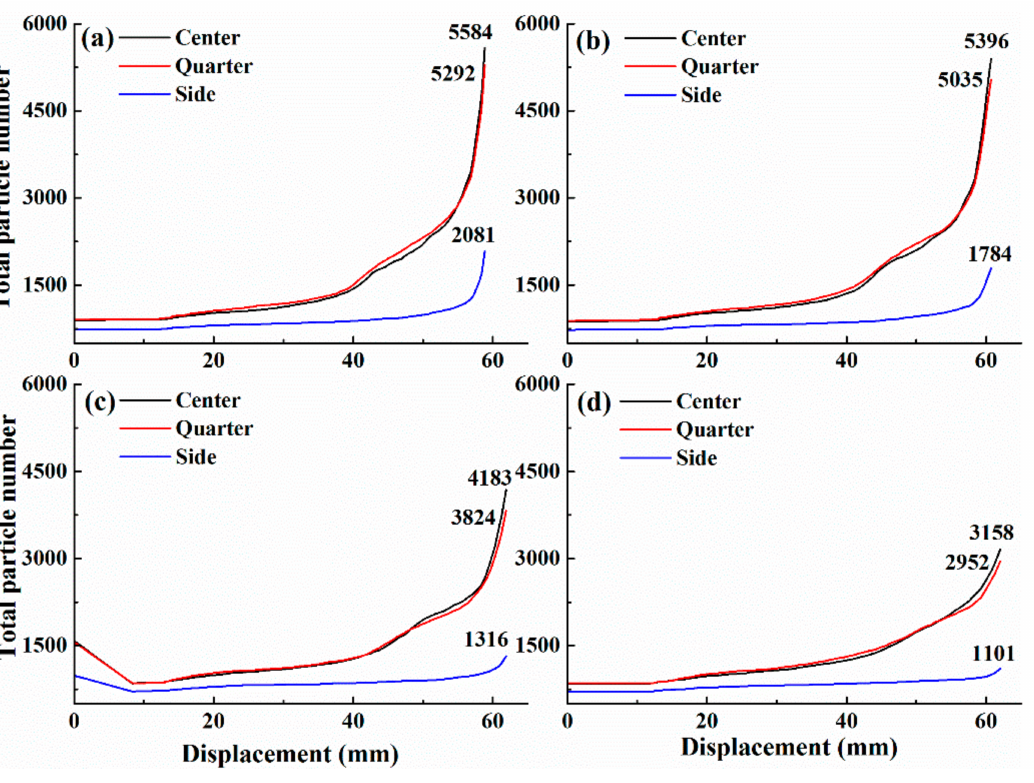
Figure 6. Total accumulated particle number on selected sections of substrate block at different